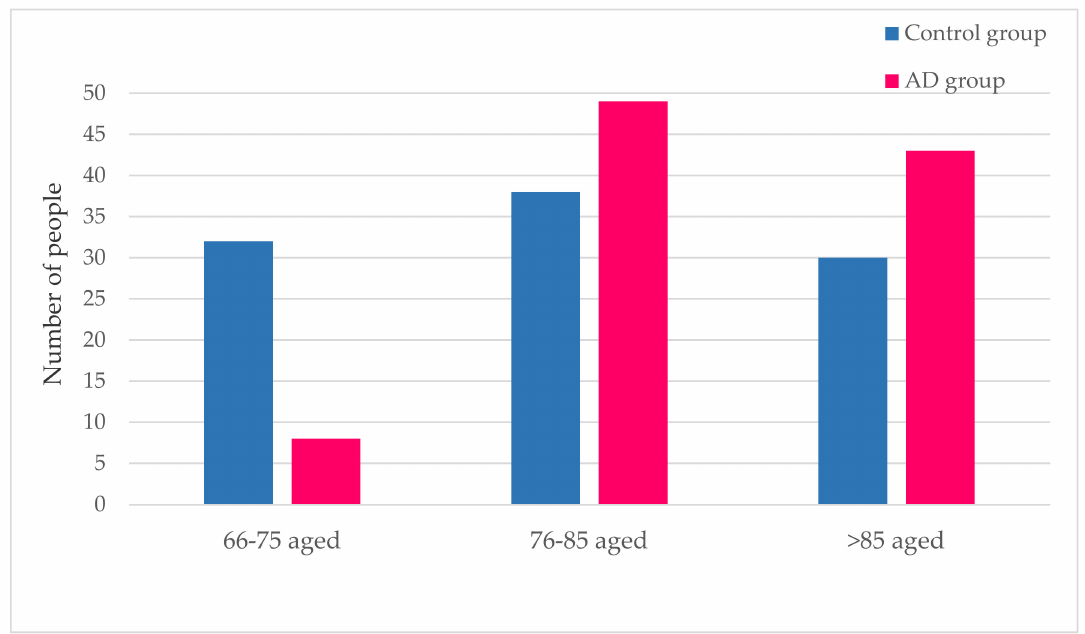
Figure 2. Age range distributions of the AD and controls. This figure shows the distribution of both the control group and the AD group, into three age range groups.